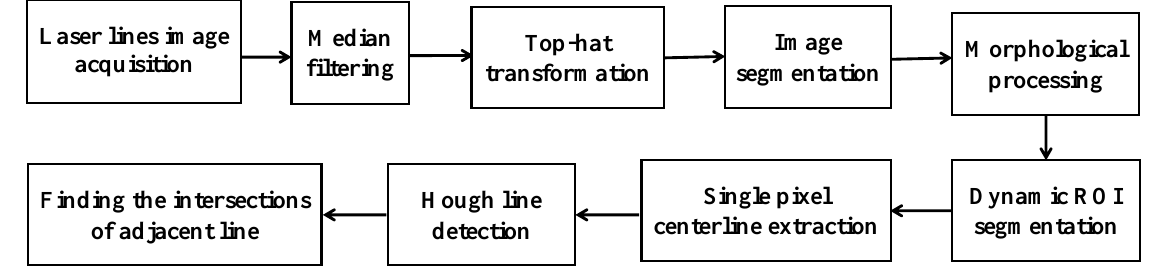
4.1. Image Processing of Modulated Laser Lines Projected on V-Groove of Planar Workpiece The laser lines projected on the V-groove surfaces and its adjacent workpiece surfaces are modulated, and then the CMOS camera captures the modulated laser lines image. The flow of processing and feature extraction of modulated laser lines image is shown in Figure 4. Laser lines image